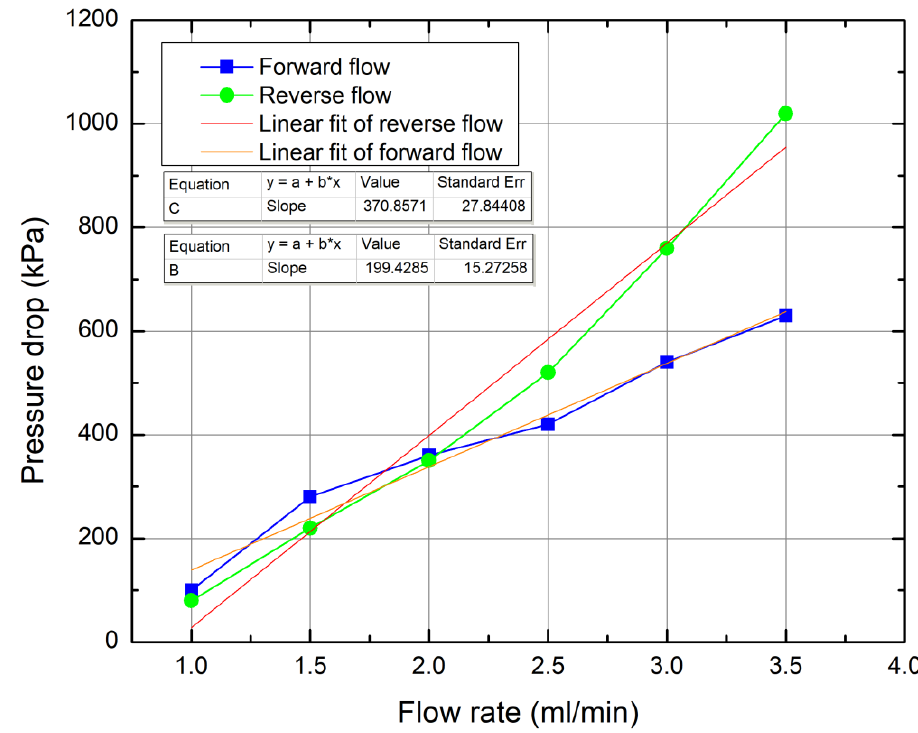
Figure 9. Pressure drop dependence on flow rate depicted